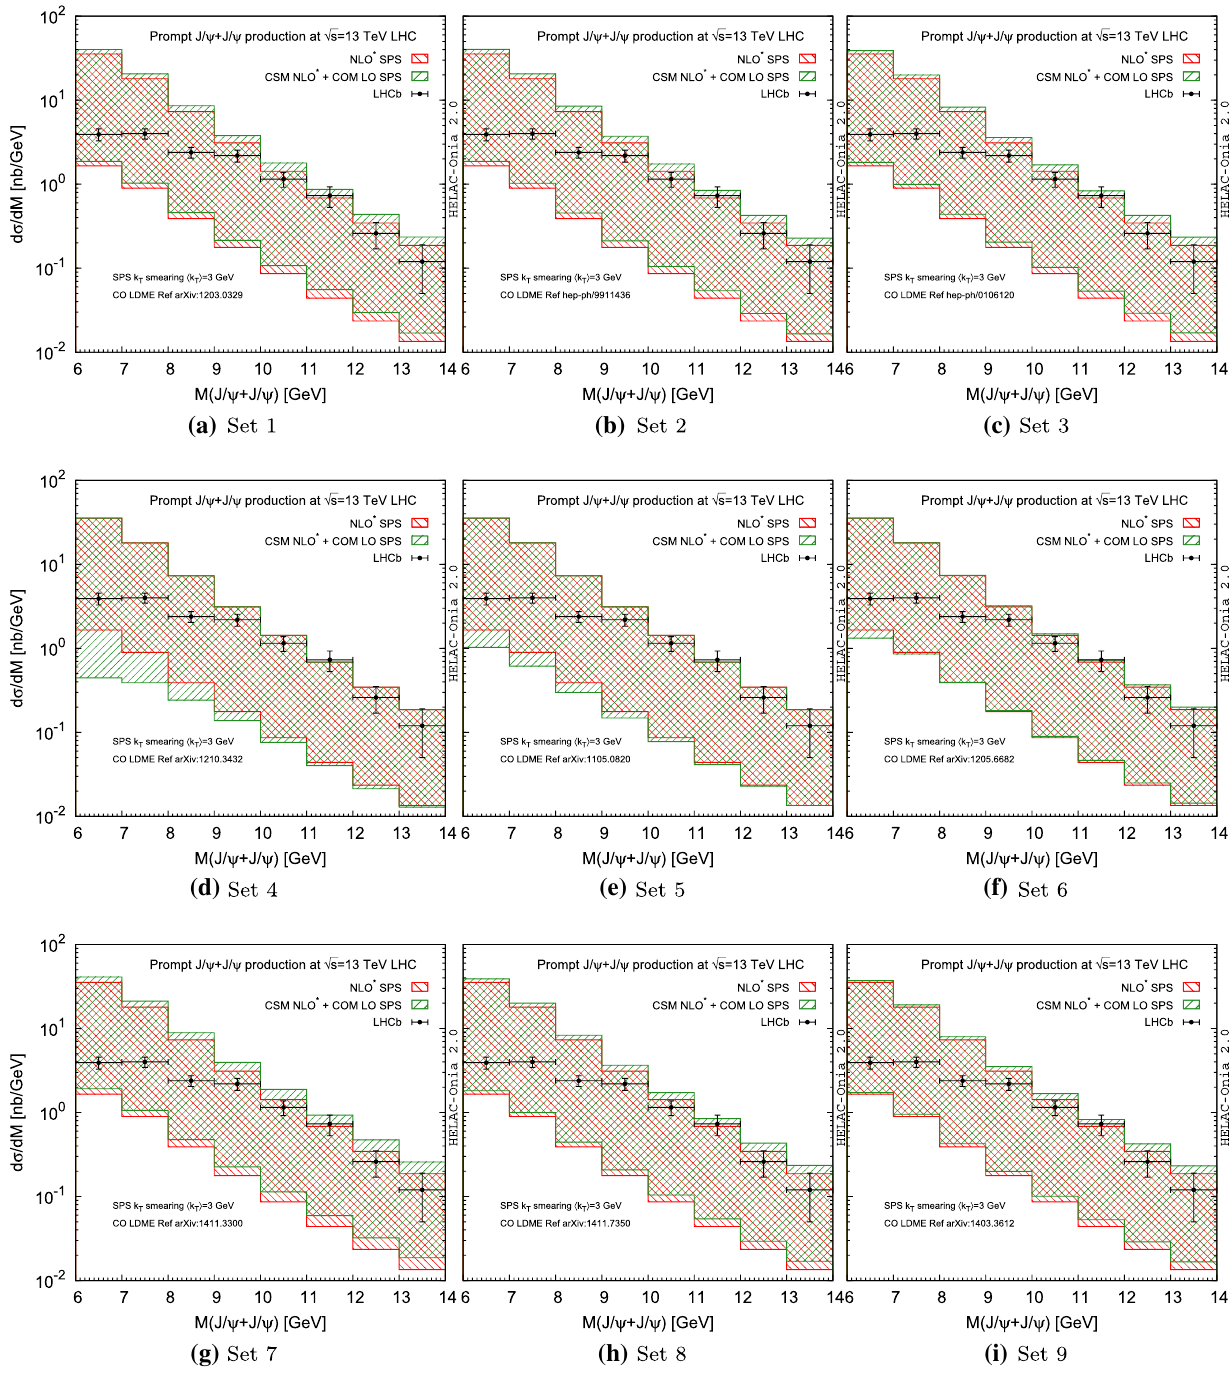
√ s = 13 TeV acceptance [23]